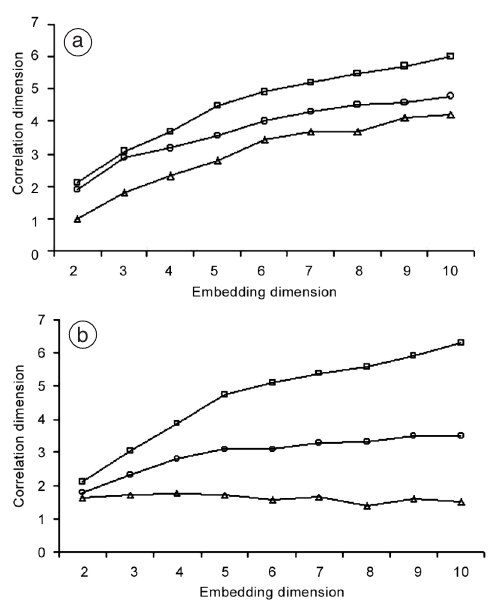
Fig. 11a,b. Correlation dimension versus embed- ding dimension of original waiting time sequences of whole catalogue (triangles) and their surrogate (cir- cles-GSRP, squares-RP): a) before beginning of ex- periments; b) during